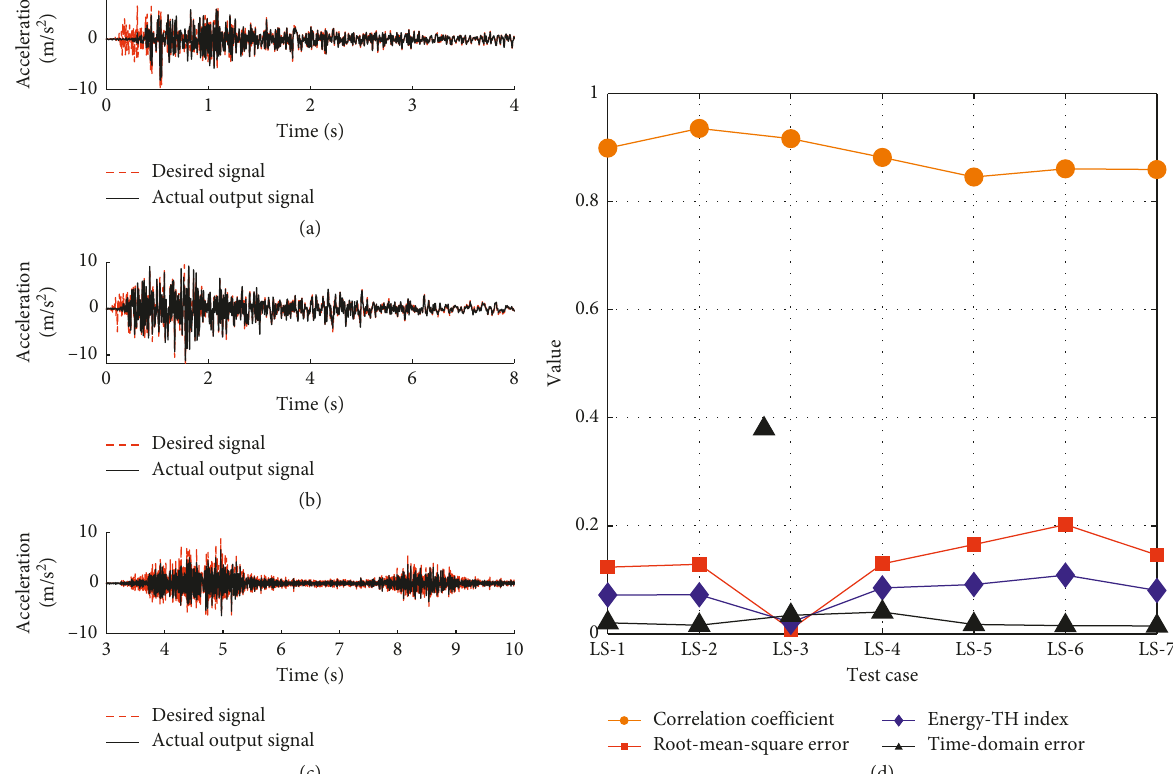
Figure 10: Shake table’s output and corresponding error of different test cases with large-span roof. (a) Case LS-1; (b) case LS-3; (c) case LS- 5; (d) output error of test